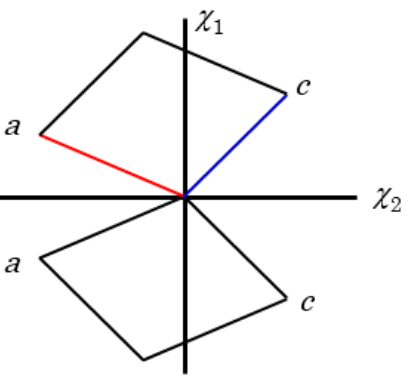
Figure 6. Twin orientation of the MOMS of α -glycine and the determination of the magnetic axes with respect to the crystallographic axes. First, twin 1 and twin 2 were placed following the relations ˆ a 1 a 2 = 46.32 ◦ , ˆ b 1 b 2 = 179.21 ◦ , and ˆ c 1 c 2 = 89.65 ◦ , where the b 1 and b 2 axes were set perpendicular to the page. Then, a two-fold rotation axis that related the two twins was drawn. Judging from the experimental procedure, this axis was assigned to the χ 2 axis. Finally, the χ 1 axis was determined to lie in the vertical direction. The angle between the c axis and the χ 1 axis was 45.18 ◦ .